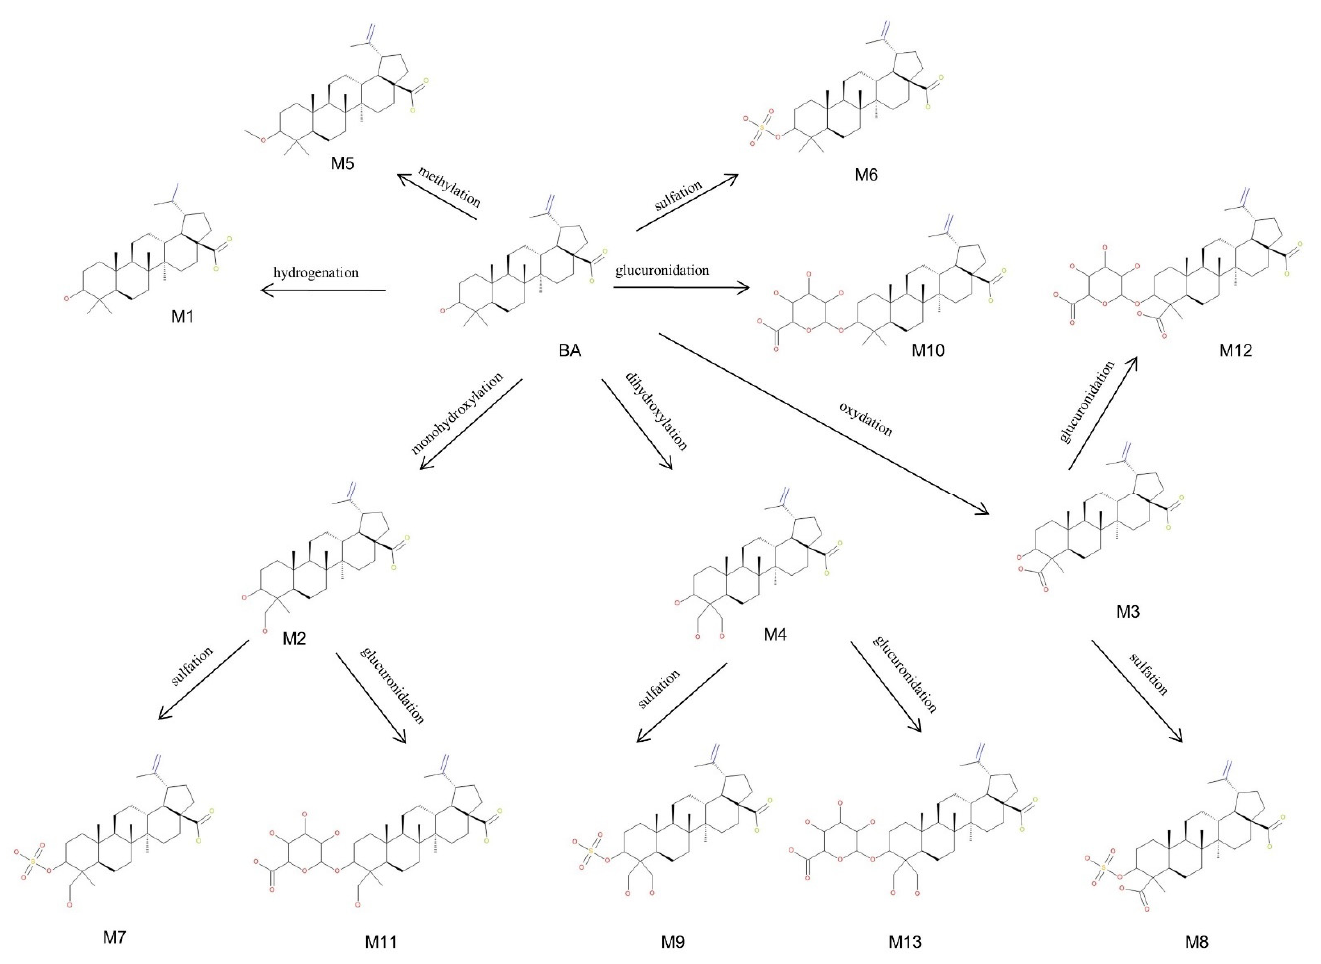
Figure 11. Proposed metabolic pathway for betulinic acid (BA) (3 β , hydroxy-lup-20(29)-en-28-oic acid) in SKH1 female mice.